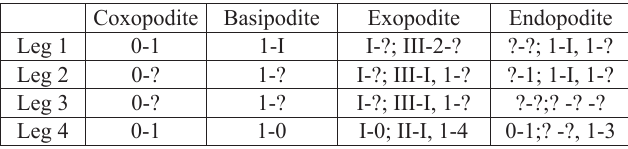
Table 4. Armature of leg 1–4 in copepodid V of Apocyclops californi- cus sp. nov. Coding system as in Table